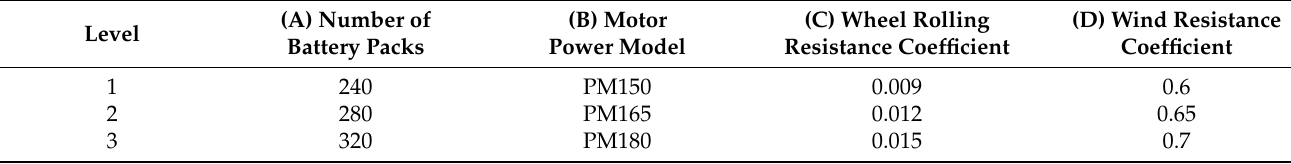
Table 8. Orthogonal experimental table.